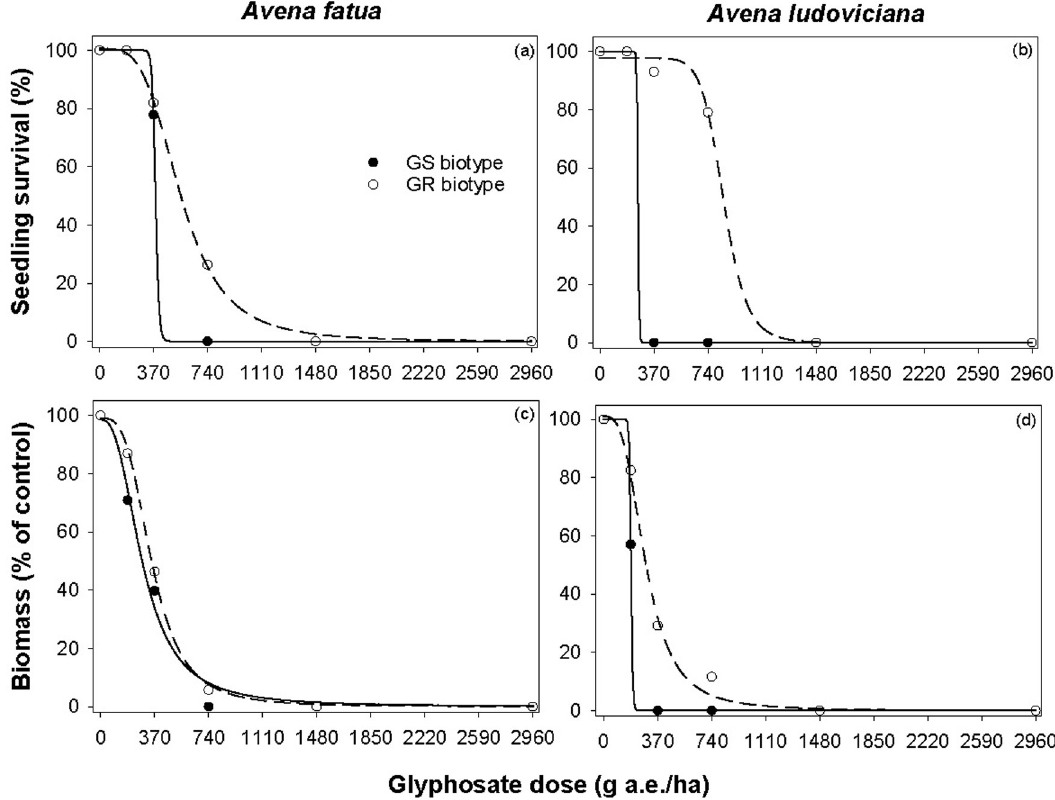
Fig 1. Effect of glyphosate dose on survival (%) (a and b) and biomass (percent of nontreated control) (c and d) of glyphosate- resistant (GR) and glyphosate-susceptible (GS) biotypes of Avena fatua (a and c) and A . ludoviciana (b and d). Plants were sprayed at the 3–4 leaf stage of each biotype.